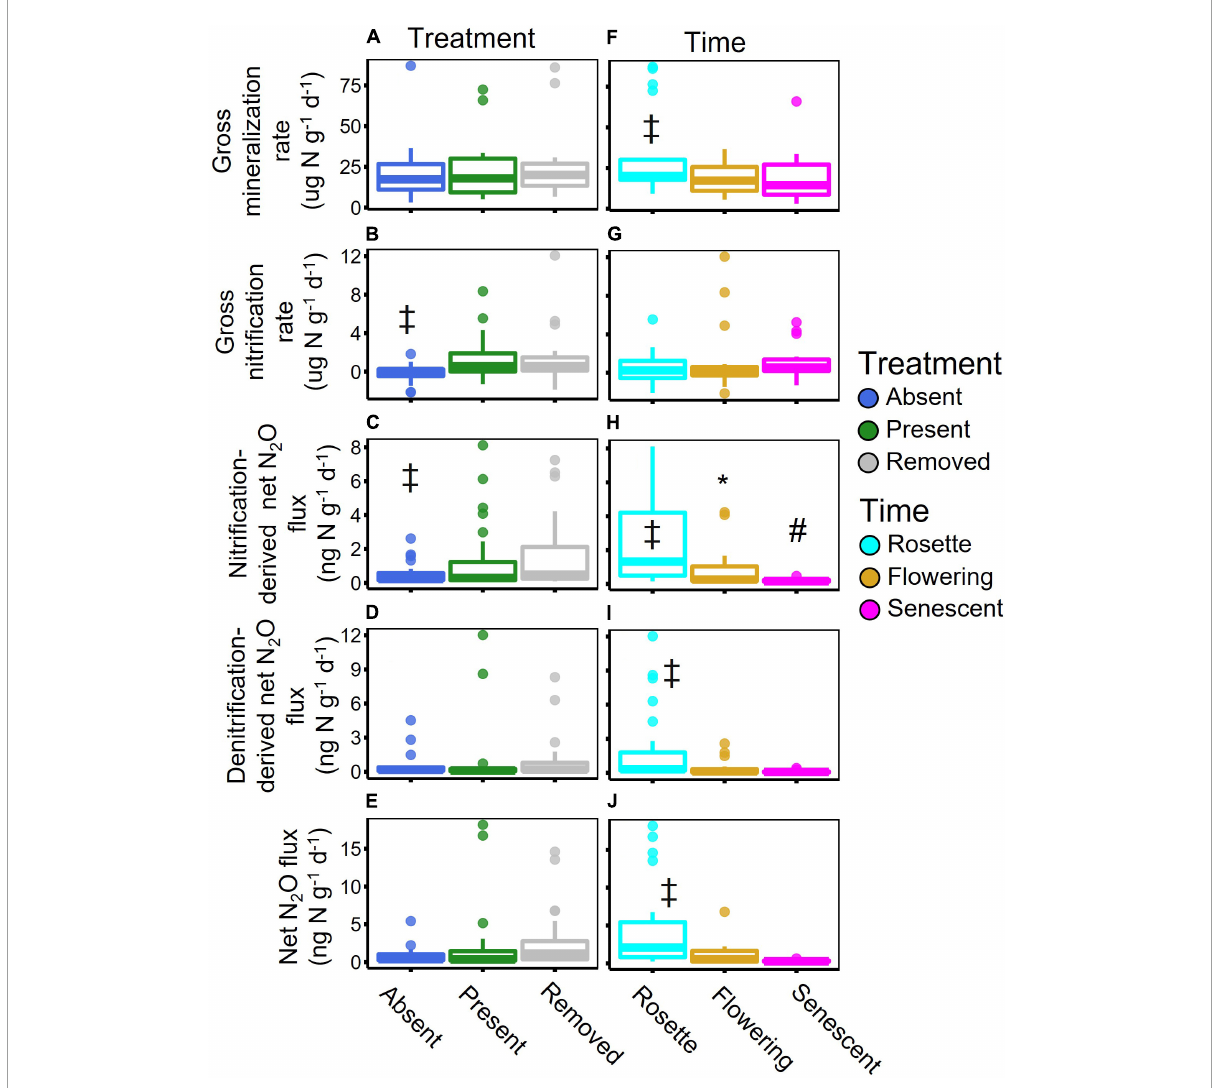
FIGURE2 Boxplots of garlic mustard treatments (A–E) and sampling time (F–J) effects for gross mineralization rates (A,F) , gross nitrification rates (B,G) , nitrification-derived net